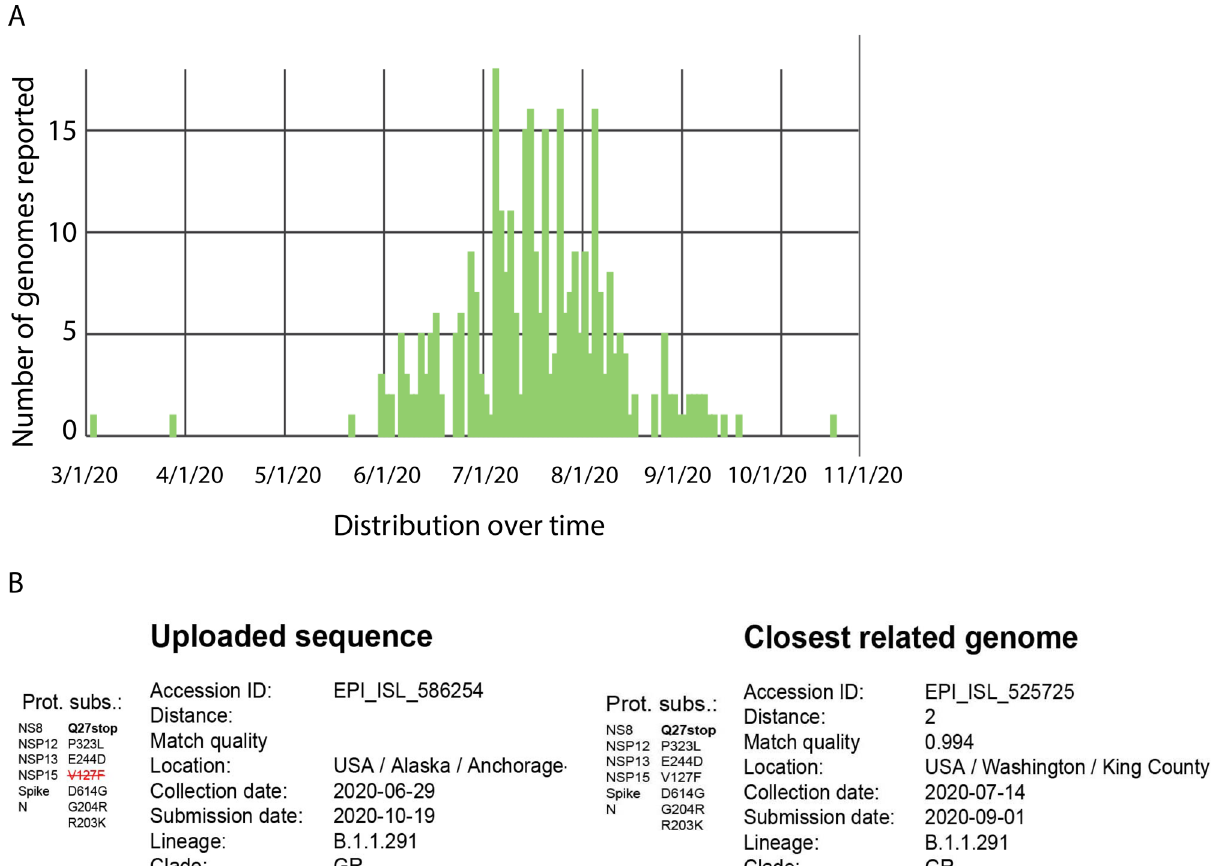
Figure 3. ( A ) Distribution over time of related genomes. A total of 340 related genomes to this novel variant (EPI_ISL_586254) have been published in GISAID with collection dates ranged from 3/6/2020 to 10/21/2020. x axis indicates the collection date, y axis is the number of related genomes published in GISAID. ( B ) The closest related genome is EPI_ISL_525725, which was collected two weeks later on 7/14/2020 in King County, Washington state, USA. A new point mutation (NSP15 V127F) occurred in EPI_ISL_525725 that was not exist in EPI_ISL_586254 (highlighted and crossed in